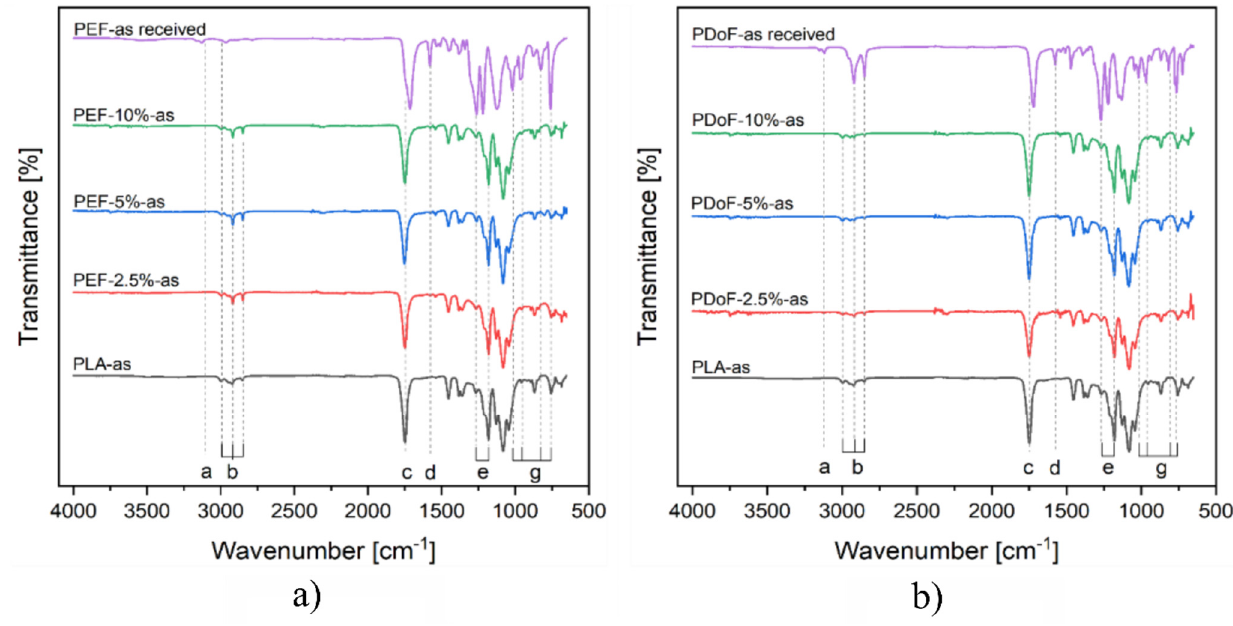
Figure 5. ATR − FTIR spectra of ( a ) PLA − as, PEF − 2.5% − as, PEF − 5% − as, PEF − 10% − as, and PEF − as received samples, ( b ) PLA − as, PDoF − 2.5% − as, PDoF − 5% − as, PDoF − 10% − as, and PDoF − as received samples.